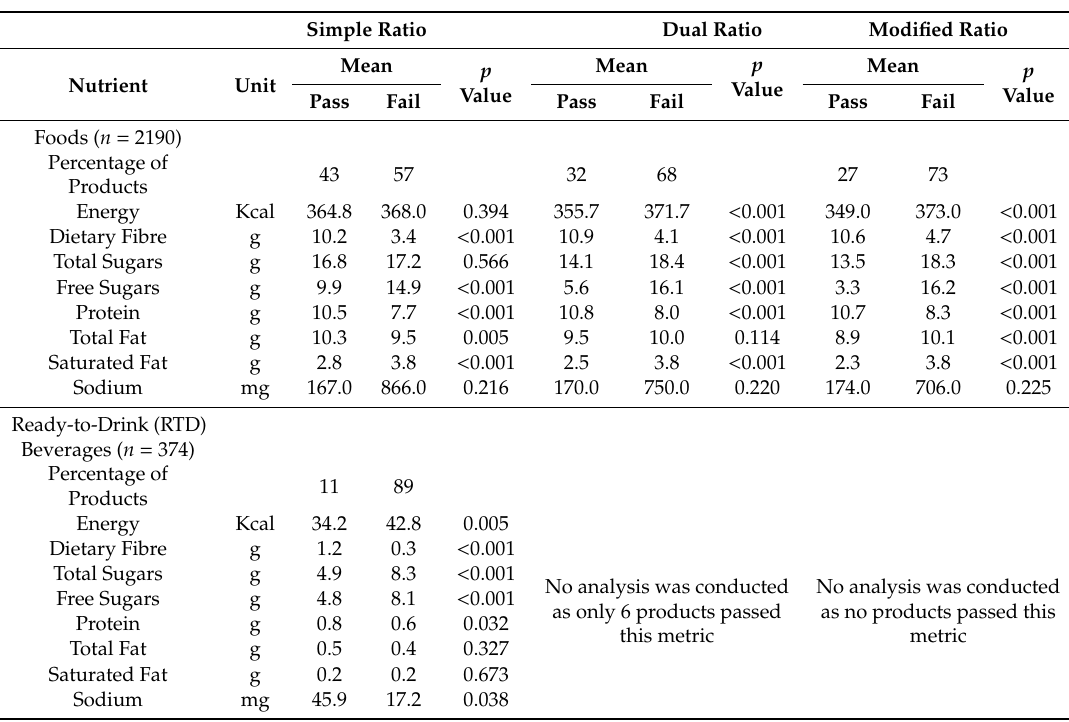
Table 3. Comparison of mean nutrient composition of carbohydrate-based packaged food and beverage products from Mintel Australia that passed or failed the three carbohydrate metrics.